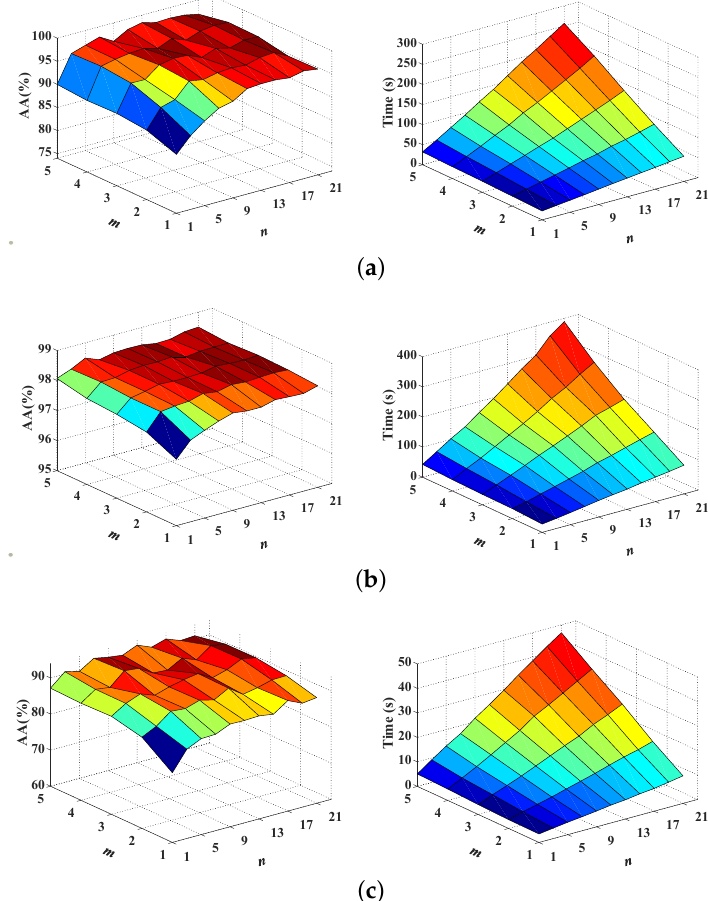
Figure 5. Classification performance and execution time of MPRN with different m and n values on the ( a ) Indian Pines, ( b ) Houston University, and ( c ) KSC data